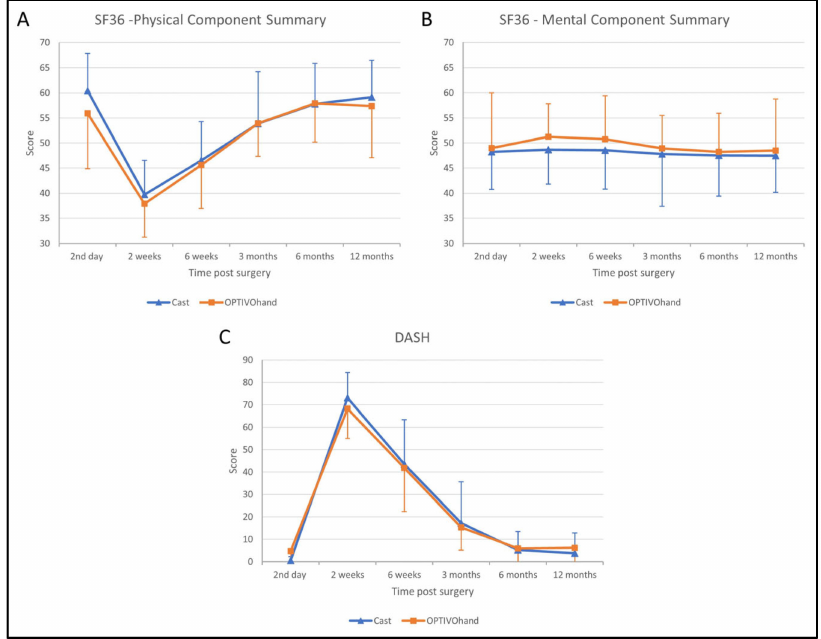
Figure 4. Patient outcome scores during follow-up (( A ) SF36—Physical Component Summary; ( B ) SF36—Mental Component Summary, ( C ) DASH). Blue triangles represent immobilization by circular cast, orange squares represent immobilization by OPTIVOhand